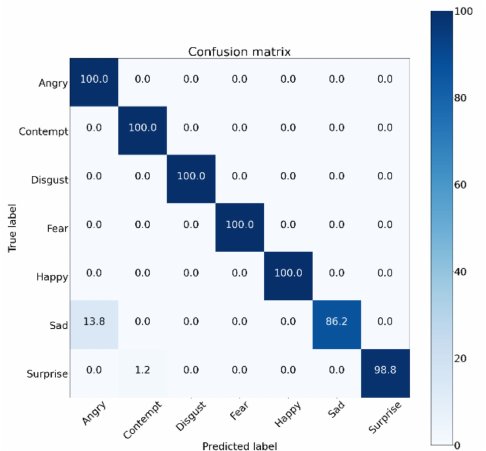
Figure 7. Confusion matrix of fused DGNN + C3D-GRU algorithms for the CK + dataset.